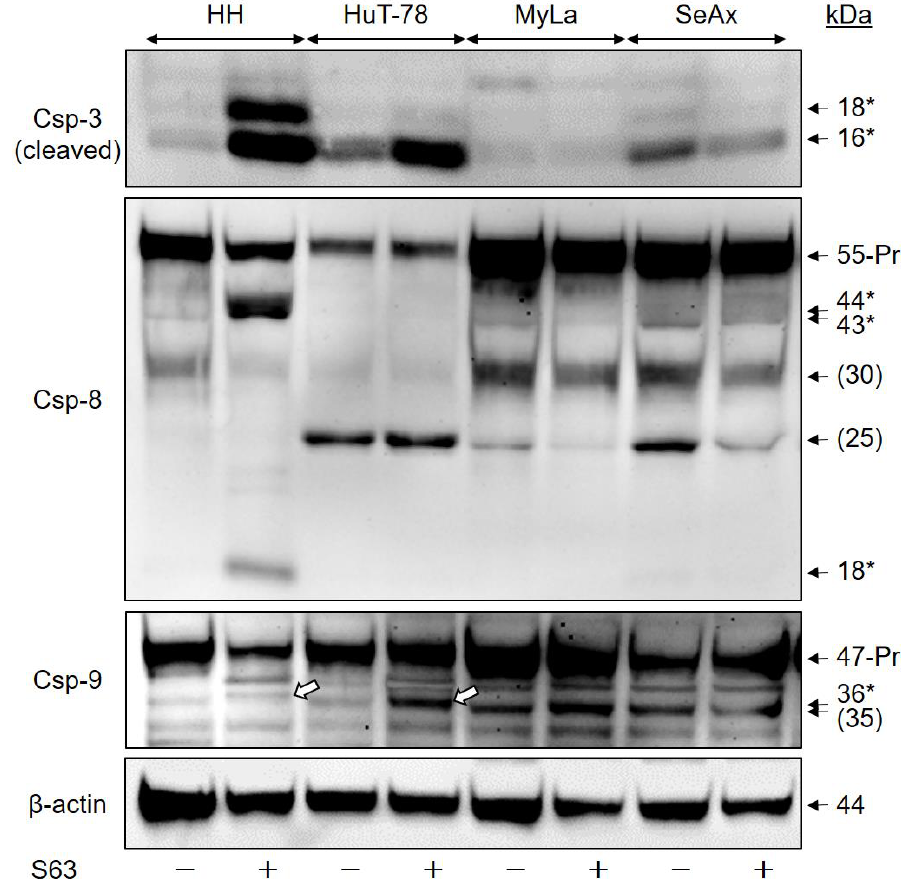
Figure 3. Caspase activation by S63845. CTCL cell lines were treated with 1 µ M S63845, and activation of caspase cascade was determined at 48 h in Western blotting by analysis of the induced, specific cleavage products, as compared to DMSO-treated controls. Each 30 µ g of proteins were loaded per lane. Blots were probed with antibodies for the cleaved forms of the major proapoptotic effector caspase-3 (cleavage products: 18, 16 kDa), for caspase-8, the initiator caspase of extrinsic pathways (proform: 55 kDa; cleavage products, 44, 43, 18 kDa) as well as for caspase-9, the initiator caspase of intrinsic pathways (proform, 47 kDa; cleavage product: 36 kDa). Specific cleavage products are indicated by (*), the cleavage products of caspase-9 (36 kDa) are further indicated by white arrows in the figure). Protein bands at 30 and 25 kDa (caspase 8) as well as 35 kDa (caspase-9) were not specified and do not reflect caspase activation (put in brackets). The housekeeping protein β -actin (44 kDa) was used as loading control. Two independent series of protein extracts and Western blotting experiments revealed highly comparable